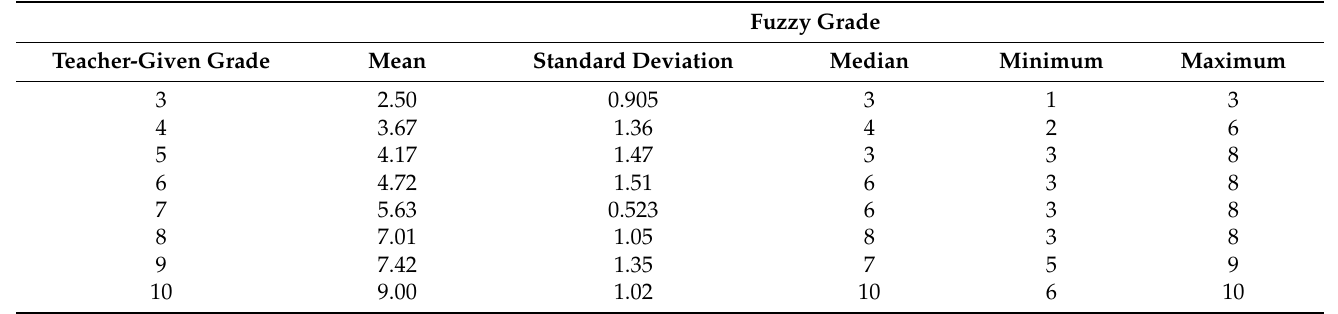
Table 8. Descriptive statistics for fuzzy grades among the levels of teacher-given grades. Fuzzy